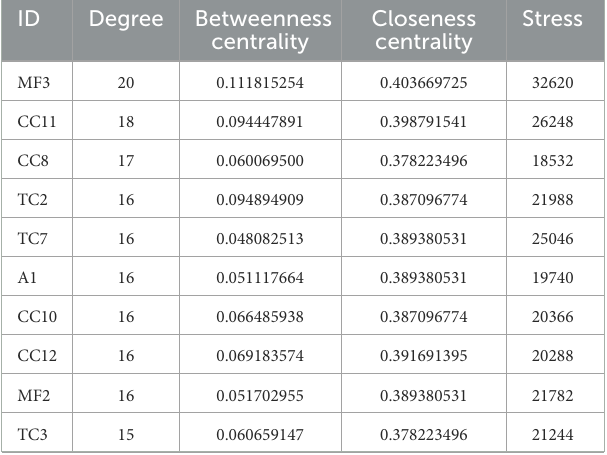
TABLE 2 Topological parameters of active